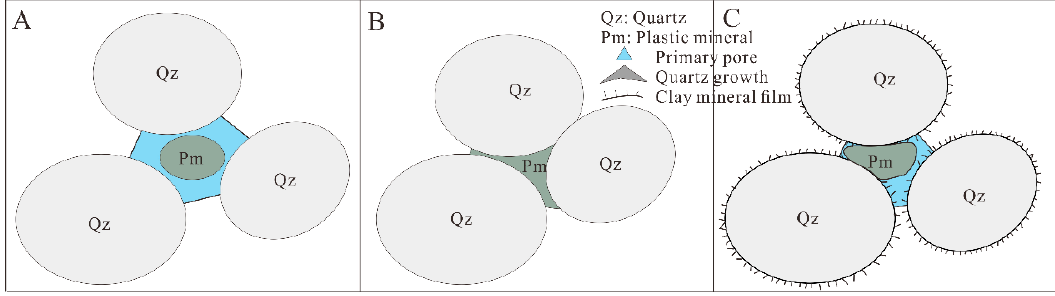
Figure 15. The relation between Chlorite content (%) based on X-ray diffraction analysis and Porosity (%) or Permeability (mD). ( A ) the relation between Chlorite content (%) based on X-ray diffraction analysis and Porosity (%); ( B ) the relation between Chlorite content (%) based on X-ray diffraction analysis and Porosity (%); ( C ) the relation between Chlorite content (>2%) (%) based on X-ray diffraction analysis and or Permeability (mD); ( D ) the relation between Chlorite content (>2%) (%) based on X-ray diffraction analysis and Permeability (mD).